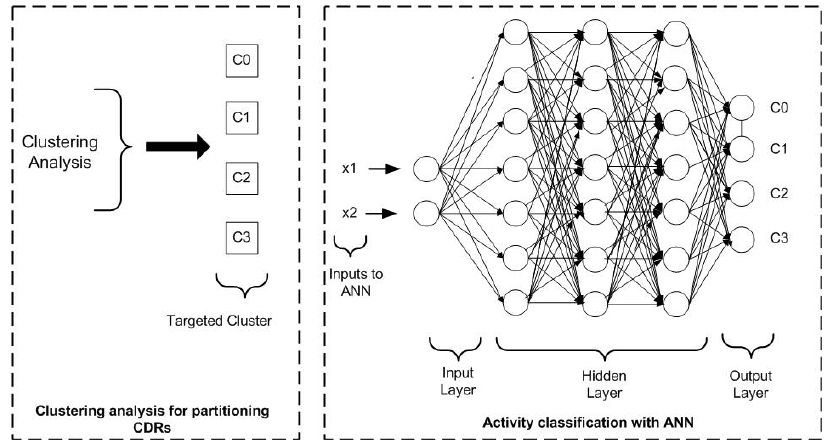
Figure 11. Activity classification with a clustering driven ANN